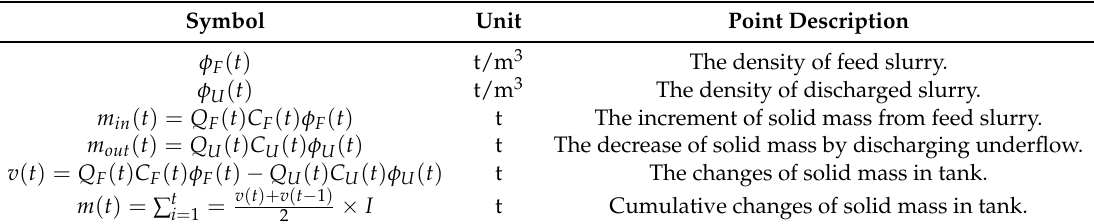
Table 3. Detailed monitoring point list in thickener system Symbol Unit Point Description φ F ( t ) t/m 3 The density of feed slurry. φ U ( t ) t/m 3 The density of discharged